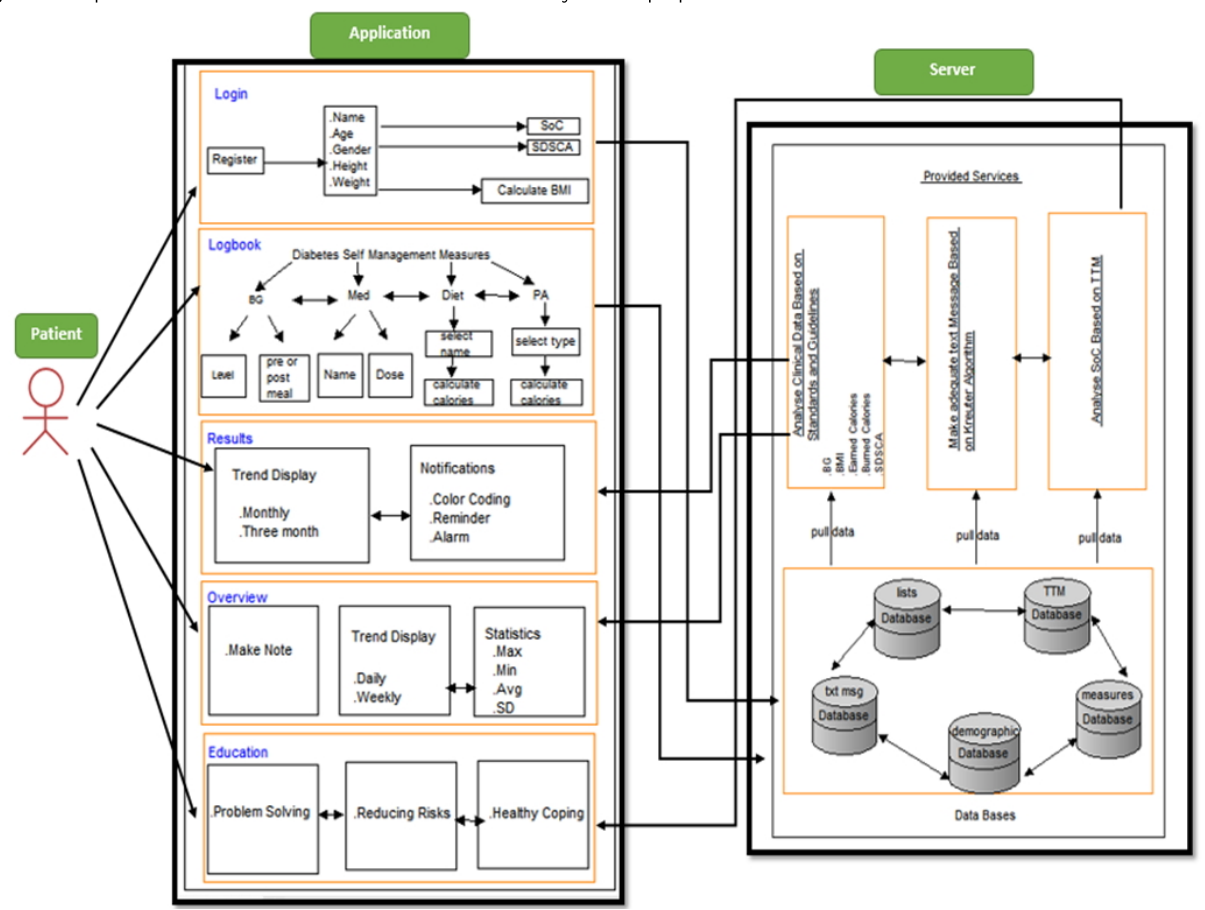
Figure 1. Proposed architectural framework for functionalities of a system for people with